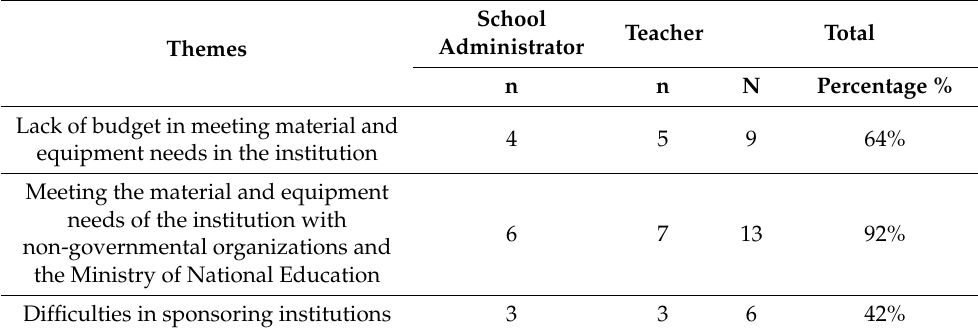
Table 2. Providing material, equipment, and equipment security needs and solutions within the scope of inclusive education of the